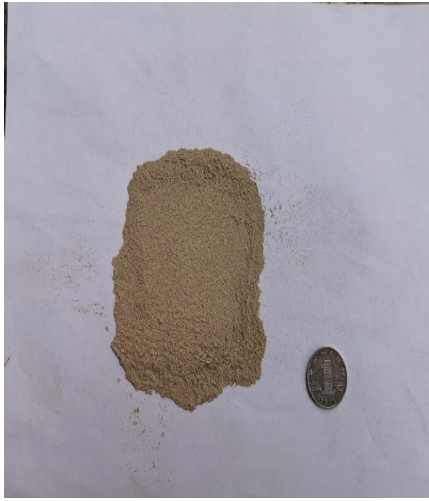
Figure 1: Waste oyster shell